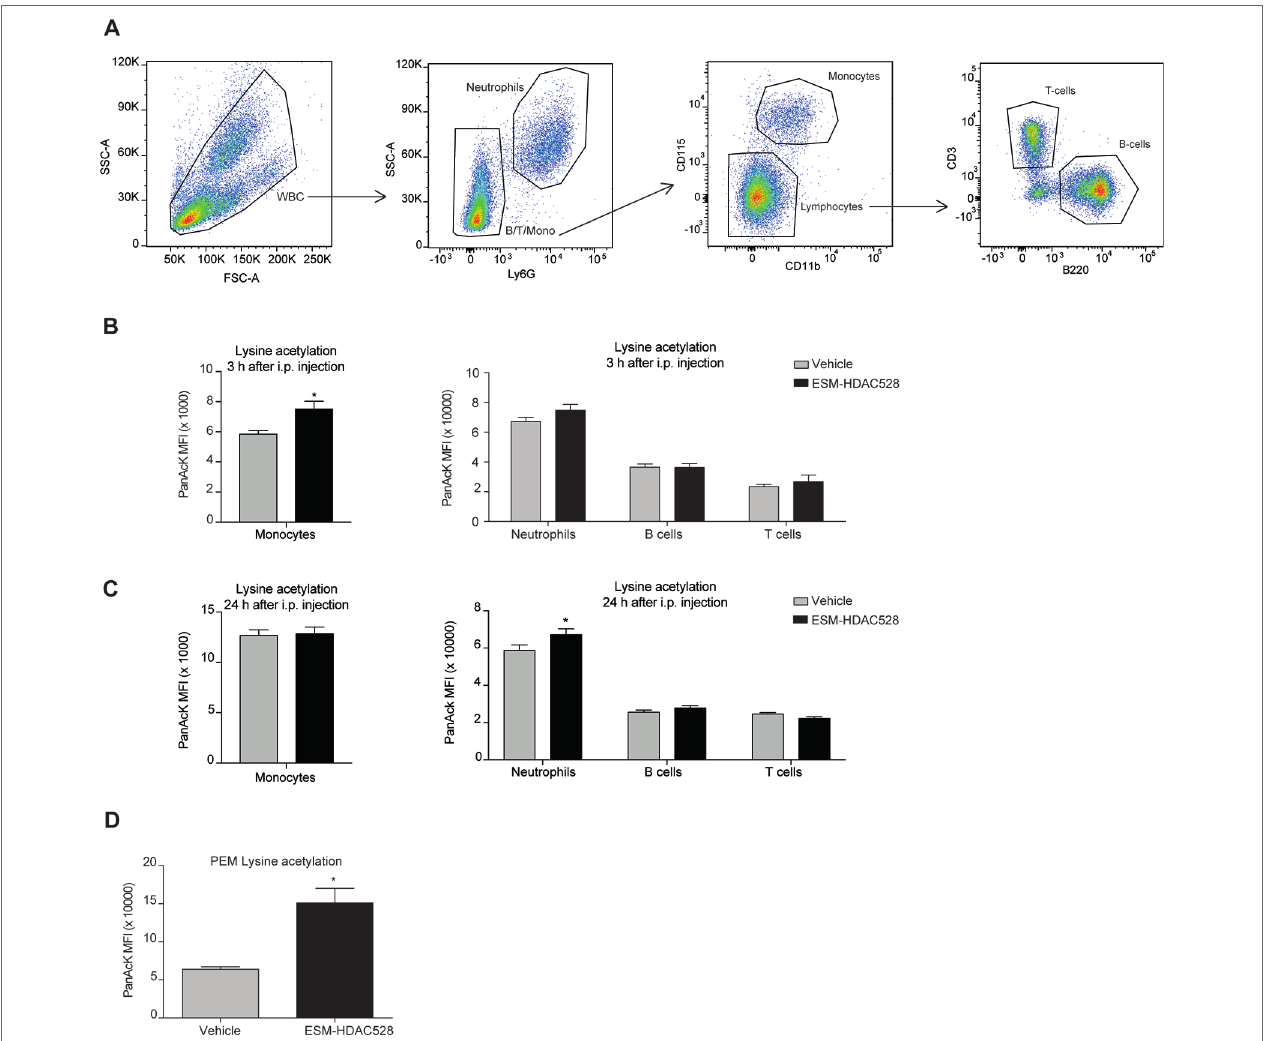
FIGURE 4 | ESM-HDAC528 selectively increases acetylation in myeloid cells. (A) Gating strategy for white blood cells after doublet exclusion. (B) MFI of intracellular acetylation levels in monocytes and other WBC 3 h after i.p. injection. n = 19 vehicle vs. n = 18 ESM-HDAC528. (C) MFI of intracellular acetylation levels in monocytes and other WBC 24 h after i.p. injection. n = 19 vehicle vs. n = 18 ESM-HDAC528. (D) MFI for intracellular acetylation levels in fresh PEMs isolated 24 h after i.p. injection. n = 5 per group. Statistical significance was determined by unpaired t -test (B and C) or two-way ANOVA with Bonferroni correction (B – D) (p < 0.05). All error bars represent the SEM. * p value ≤